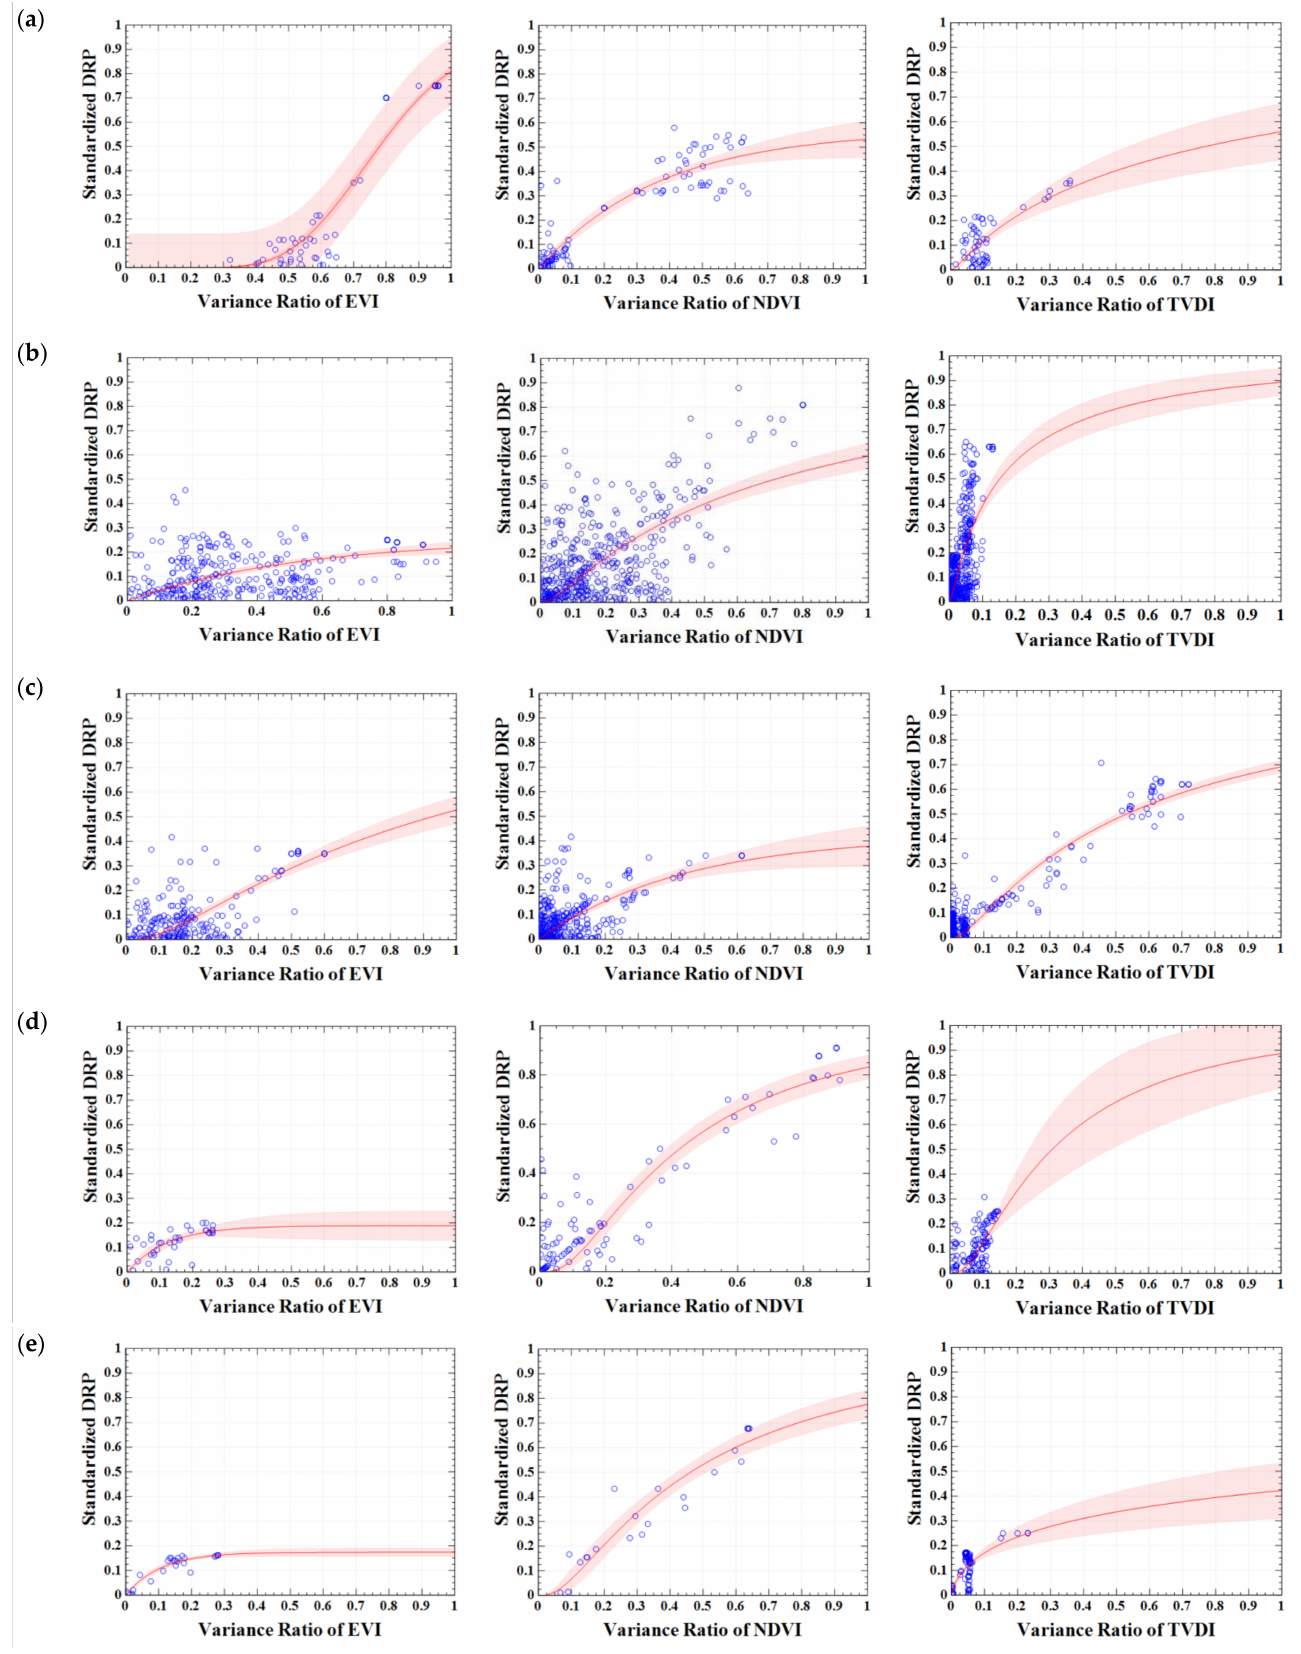
Figure 7. Vulnerability curves for the five regions of China: ( a ) NW; ( b ) SW; ( c ) HJ; ( d ) AP; and ( e )